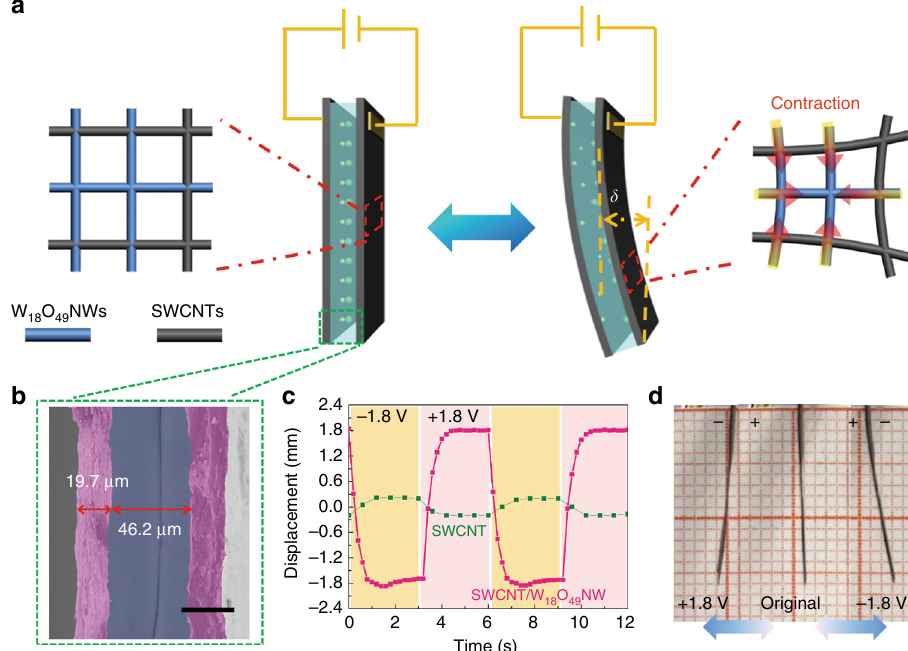
Fig. 4 The structure and performance of pseudocapacitive ionic polymer metal composite actuators. a Schematic illustrations of the assembled con fi guration and electrochemical actuating mechanism of a pseudocapacitive ionic polymer metal composite (IPMC) actuator; b Typical cross-sectional scanning electron microscopy (SEM) image of a pseudocapacitive IPMC actuator (Scale bar: 30 μ m); c Respective bending displacements of the pseudocapacitive IPMC and pure single-wall carbon nanotubes (SWCNTs)-based IPMC actuators measured between ± 1.8 V bias; d The